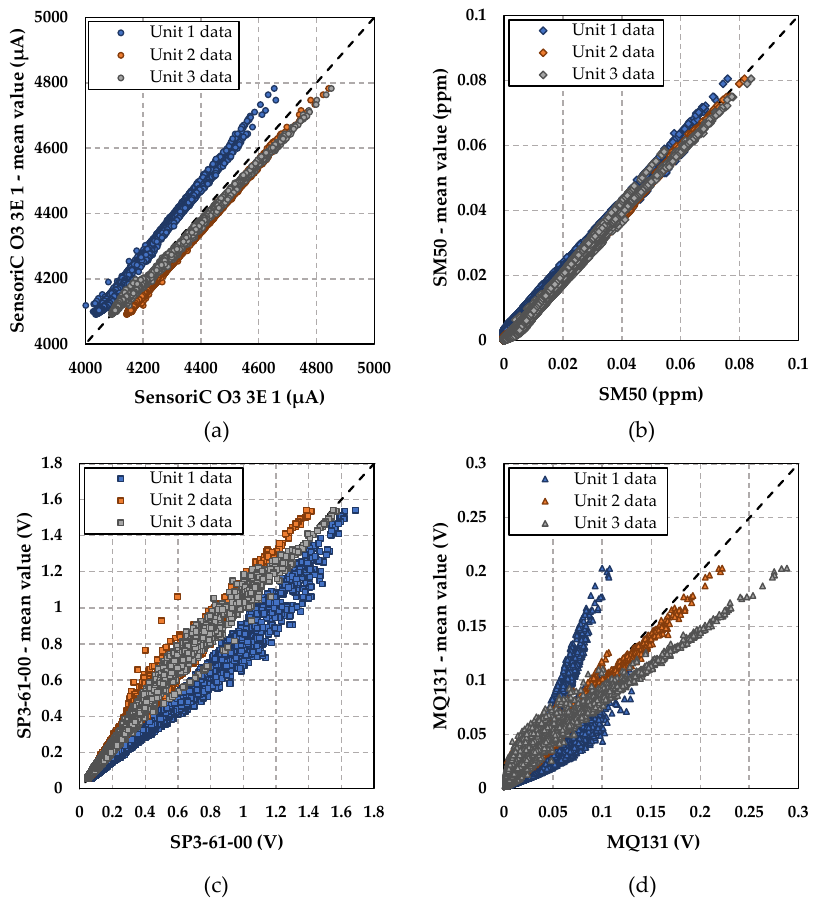
Figure 2. Scatterplots of signals from sensors units vs. the mean values of the 1-h averaged data: ( a ) SensoriC O3 3E 1 (City Technology); ( b ) SM50 (Aeroqual); ( c ) SP3-61-00 (FIS); and ( d ) MQ131 (Winsen). Dashed lines denote the ideal relationship.